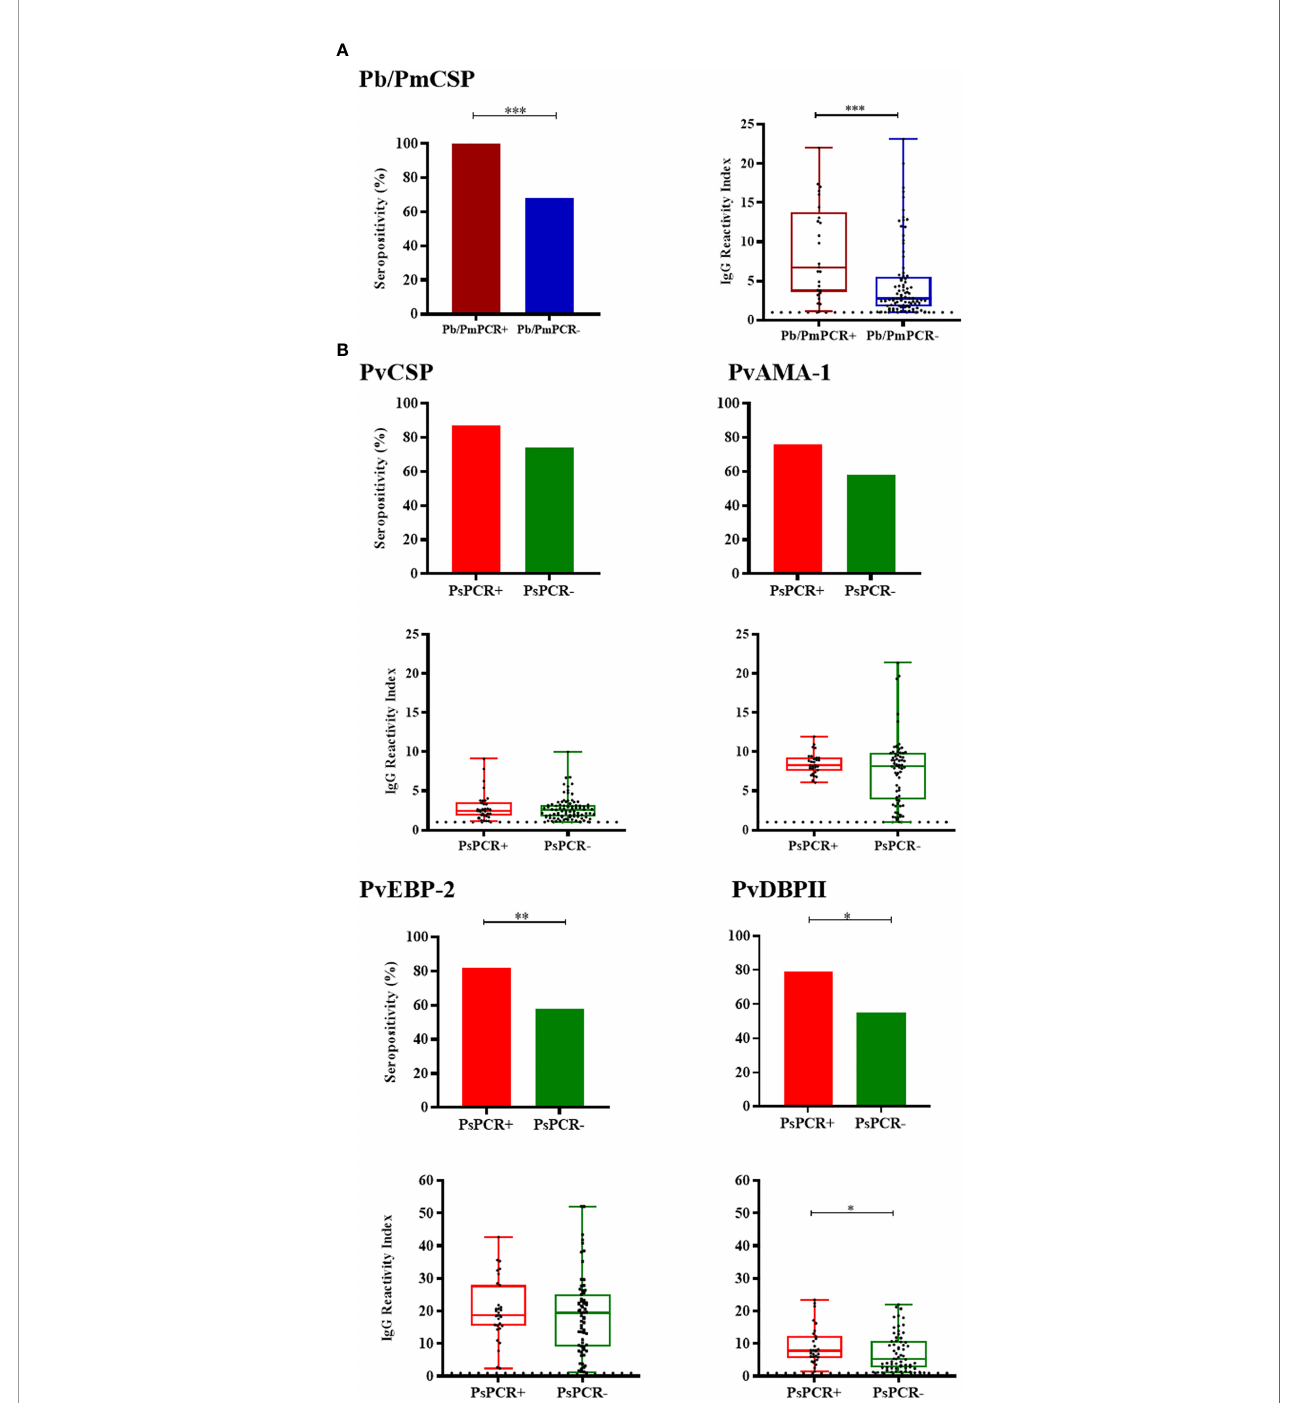
FIGURE 5 | Prevalence and levels of antibodies against Plasmodium antigens according to PCR positivity for Plasmodium species. (A) Seropositivity and reactivity index (RI) of IgG antibodies against P. brasilianum/P. malariae CSP peptide in monkeys with PCR positive for P. brasilianum/P. malariae (Pb/PmPCR+, dark red) or negative (Pb/PmPCR-, blue). (B) Seropositivity and RI of IgG antibodies against P. vivax CSP and erythrocytic antigens in monkeys with PCR positive for P. simium (PsPCR+, red) or negative (PsPCR-, green). RI > 1 was considered positive (dotted line). The fi lled bars indicate the percentage of NP with RI > 1 ( A , B top). Data expressed as individual RI values (dots) and median with the interquartile range (boxes) ( A , B botton). Pb/PmCSP: CSP repeat of P. brasilianum/P. malariae ; PvCSP: CSP repeats representing P. vivax CSP repeats (VK210, VK247, and P. vivax -like); PvAMA-1: P. vivax Apical membrane antigen – 1; PvEBP-2: P. vivax Erythrocyte Binding Protein 2; PvDBPII: P. vivax Duffy Binding Protein region II. Differences statistically signi fi cant were indicated by asterisk (* P < 0.05; ** P < 0.01; *** P <